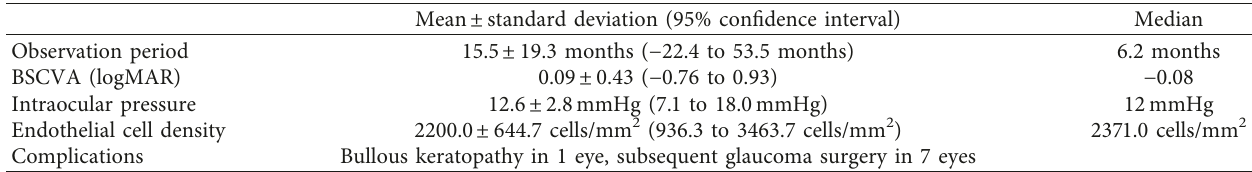
Table 2: Posttreated outcomes of the best spectacle-corrected visual acuity, the intraocular pressure, and the endothelial cell density for acute primary angle closure in the whole study population.